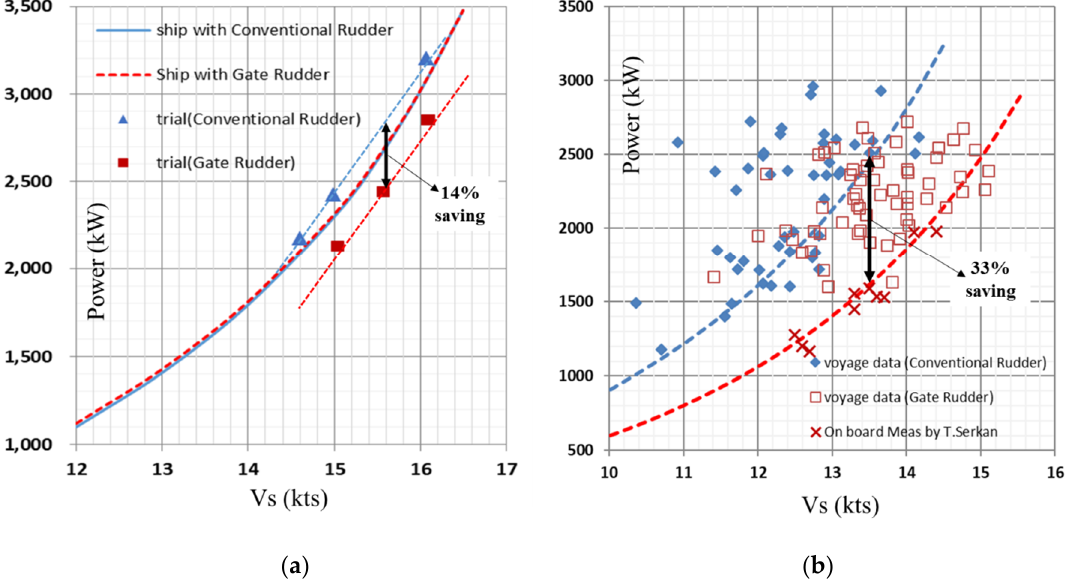
Figure 3. Powering performance comparisons of two sister ships, one with a gate rudder system and